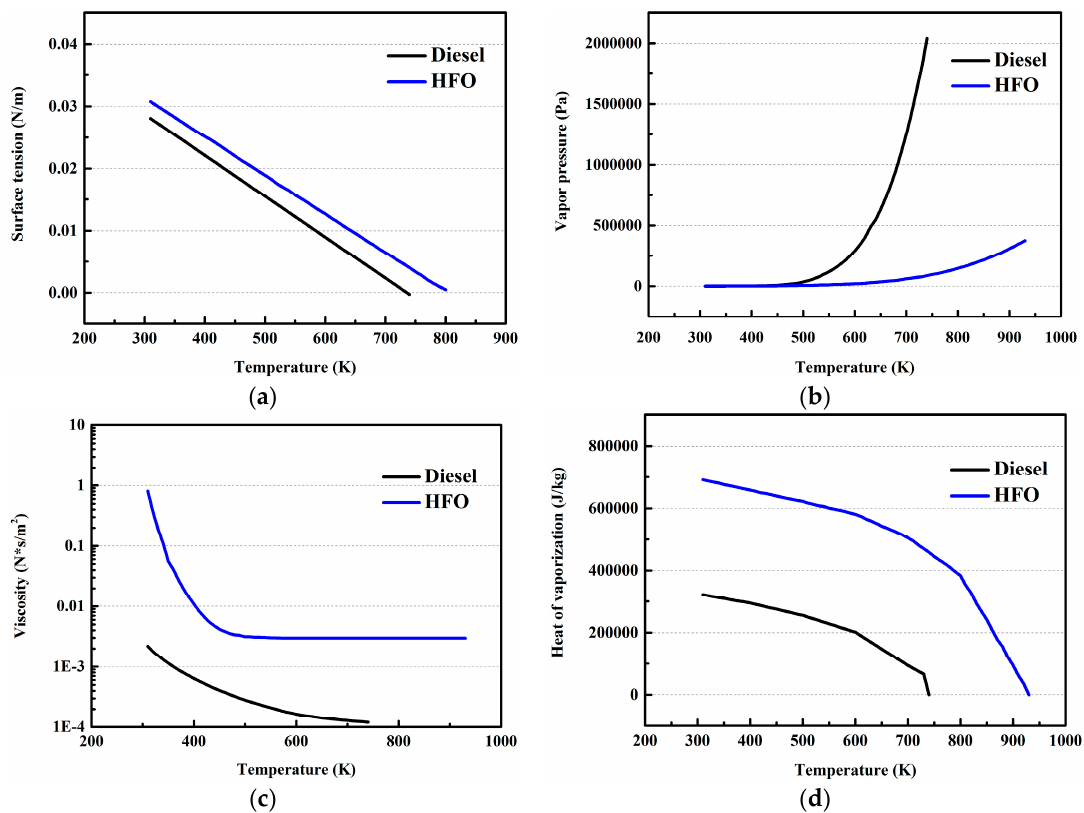
Figure 1. Computational grids for RFCVCC, FIA, and 340 marine engine simulations.( a ) RFCVCC for non-reacting simulations; ( b ) FIA for combustion simulations; ( c ) 340 marine engine simulations.